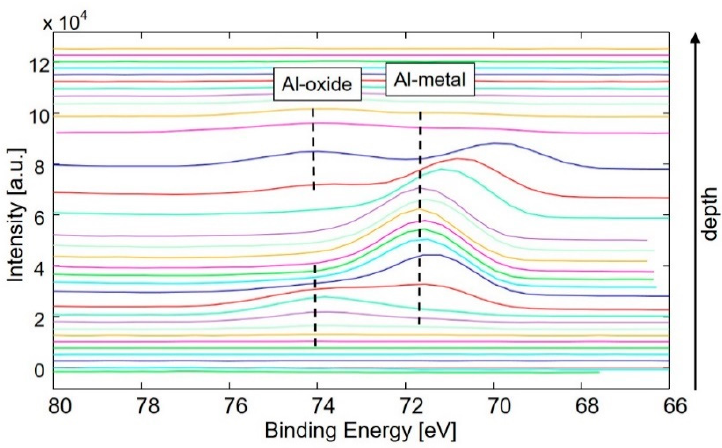
Figure 7. Al 2 p spectra obtained during XPS depth profiling of the deposited sample.